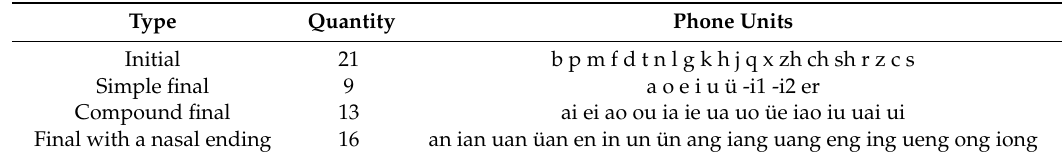
Table 1. A list of initials and finals in Mandarin.